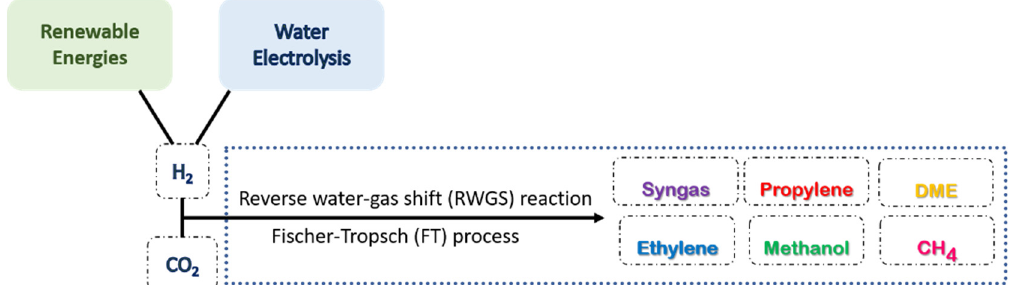
Figure 24. Main products from CO 2 hydrogenation.